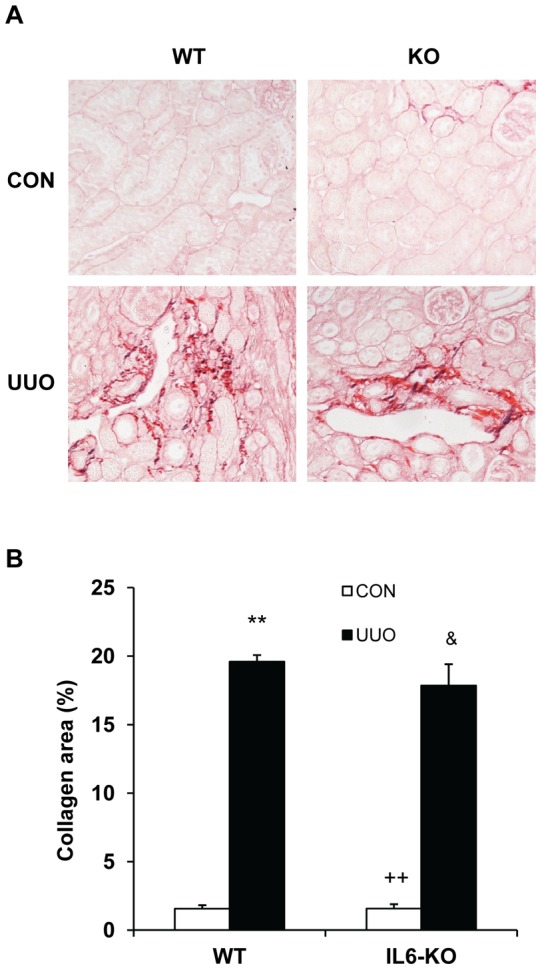
Effect of IL-6 deficiency on renal fibrosis and extracellular matrix deposition in the kidney.
A. Representative photomicrographs show kidney sections stained with picrosirius red for assessment of total collagen deposition. B. Bar graph shows quantitative analysis of renal interstitial collagen in different groups as indicated. ** P<0.01 vs WT control, &
P>0.05 vs WT UUO, and ++
P<0.01 vs KO UUO. n = 5 per group.